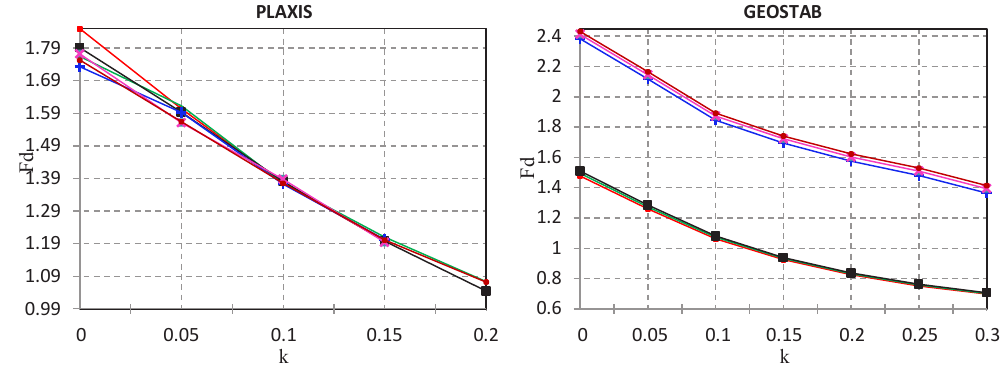
Figure 16: Effect of the upstream unit’s weight with PLAXIS and GEOSTAB.